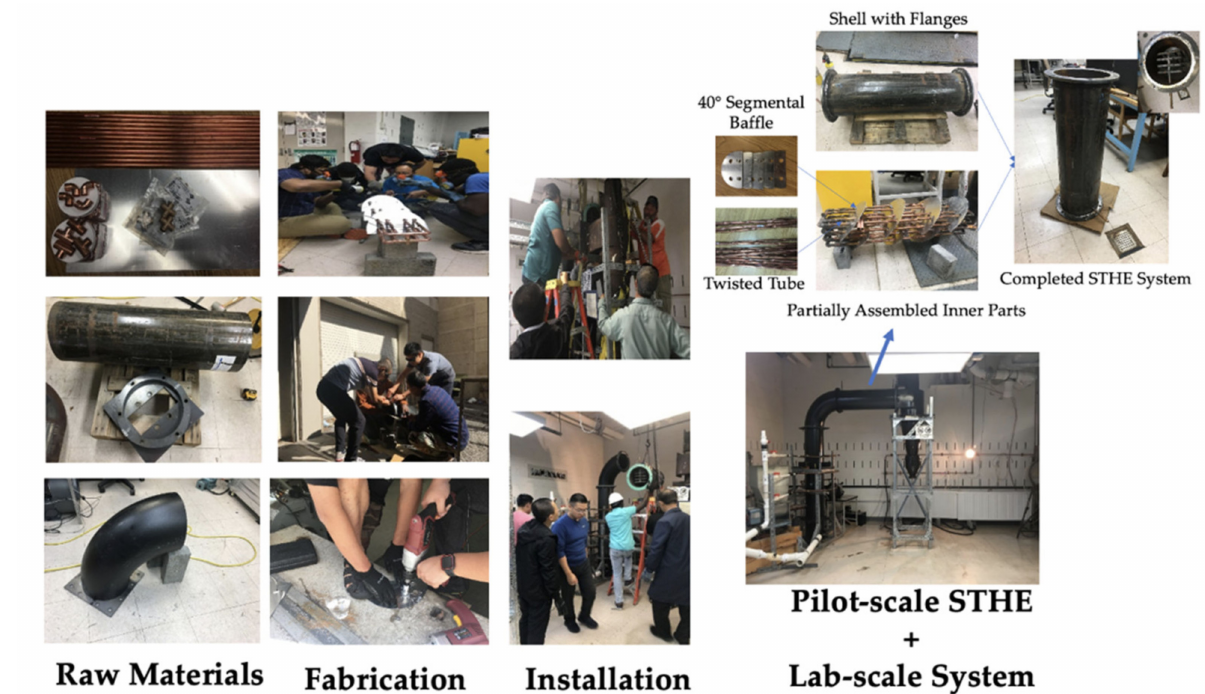
Figure 2. Pilot-scale shell and tube heat exchanger (STHE) system, fabrication, and